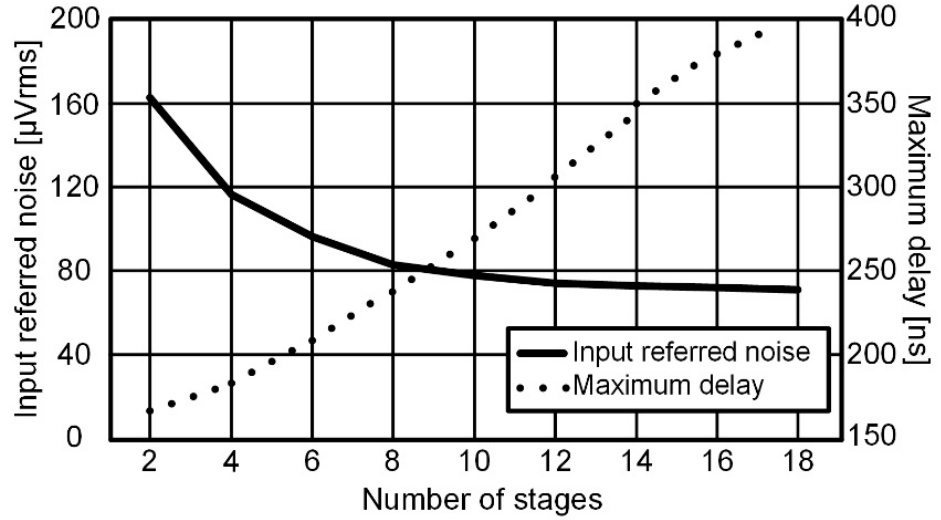
Figure 5. Maximum delay and input-referred noise of VCDL according to the number of stages.